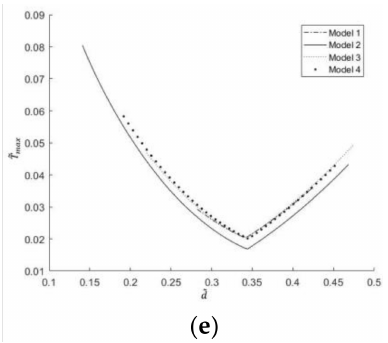
Figure 6. The relationship among N , (cid:101) d and (cid:101) T max when ϕ = 15%. Where subfigures ( a – e ) are N = 2–6